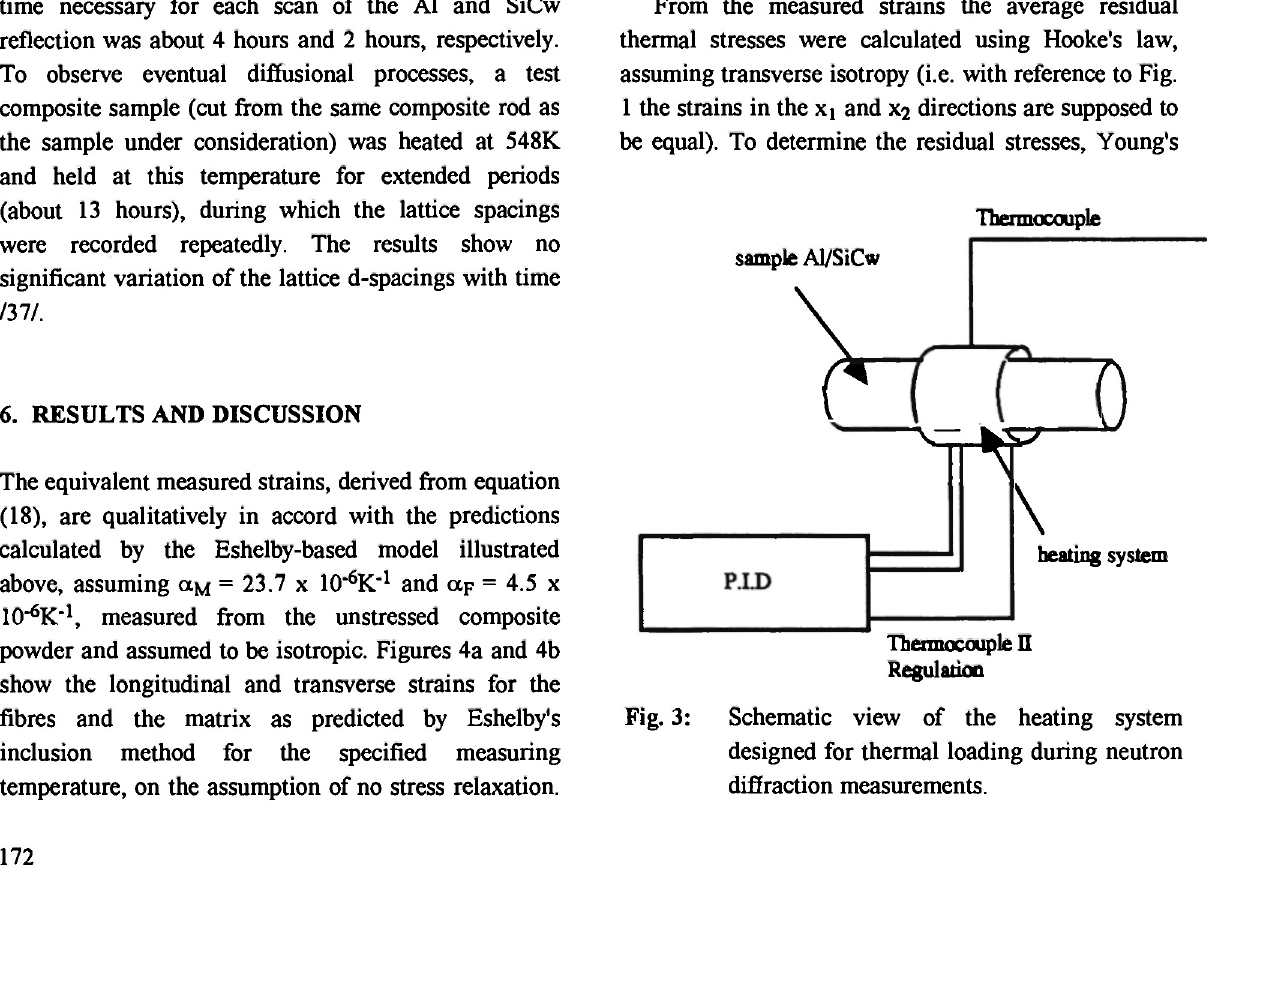
Fig. 3: Schematic view of the heating system designed for thermal loading during neutron diffraction